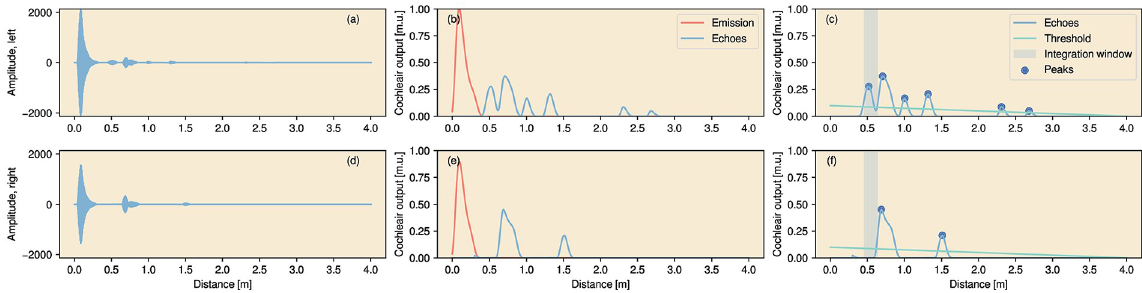
Fig 2. Illustration of the echo processing. (a) The signal at the left ear, containing the emission and the echoes. (b) The output of the cochlear model [33]. The emission (shown in red) is subtracted from this result. (c) Peaks in the output of the cochlear model that surpass a given threshold (in green) are considered as echoes. The energy in a window of 1 ms around the arrival time of the first echo in the left or the right ear is integrated. (d-f) Same for the right ear. In this example, the first detectable echo arrives at the left